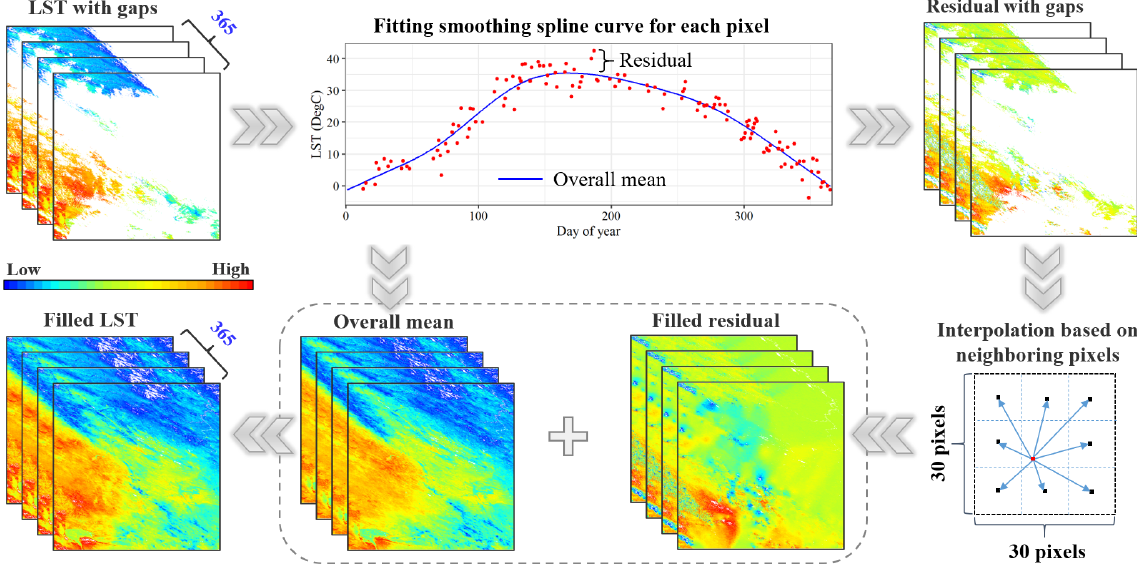
Figure 3. An example of the spatiotemporal fitting algorithm for gap-filling LST.